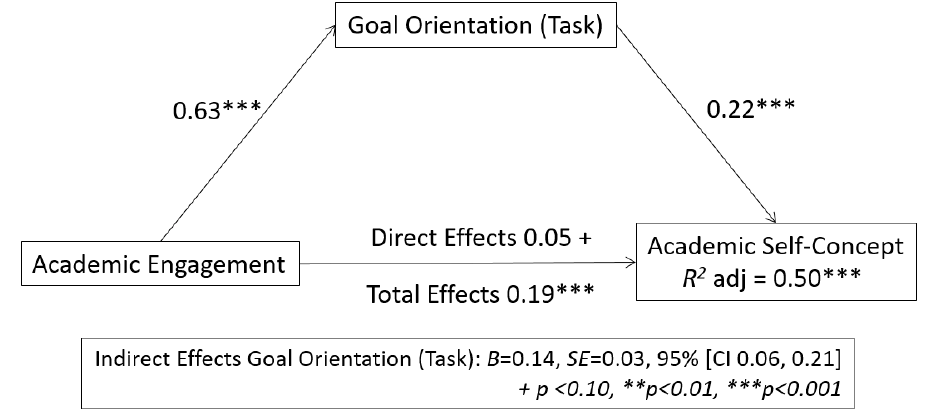
Figure 1. Mediation model of (task) goal orientation in the relationship between academic engagement and academic self-concept variables. + p < 0.10, ** p < 0.01, *** p <